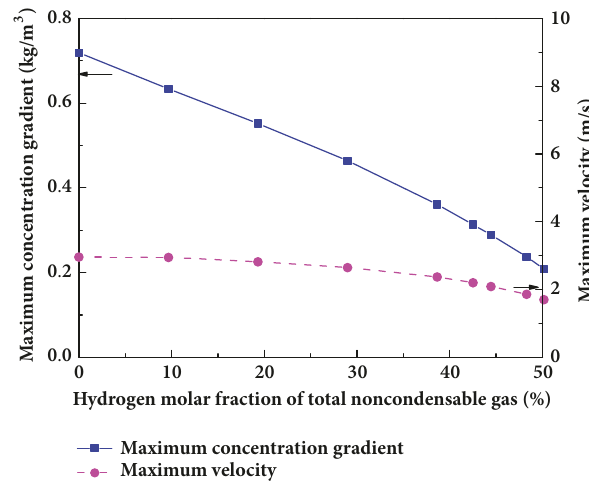
Figure 19: Maximum concentration gradient and velocity with different hydrogen molar fractions.